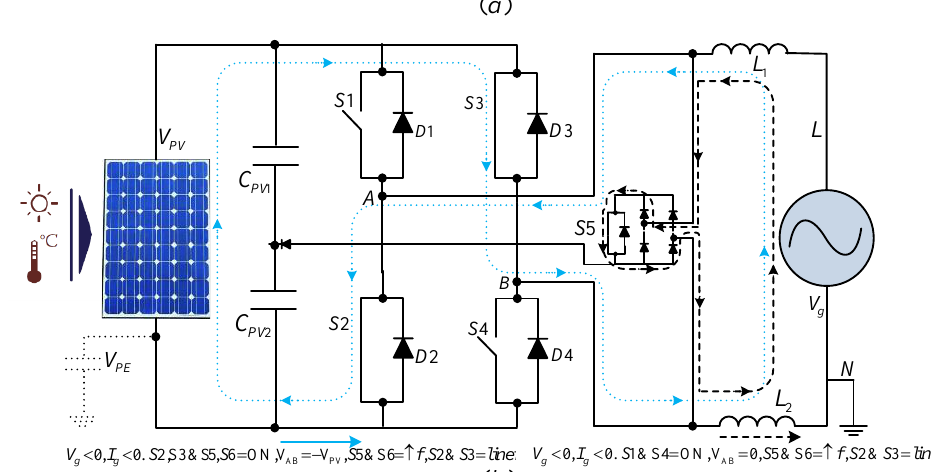
Figure 16. Switching positions of FB-ZVR in case of ( a ) positive cycle and ( b ) negative cycle [43,56].